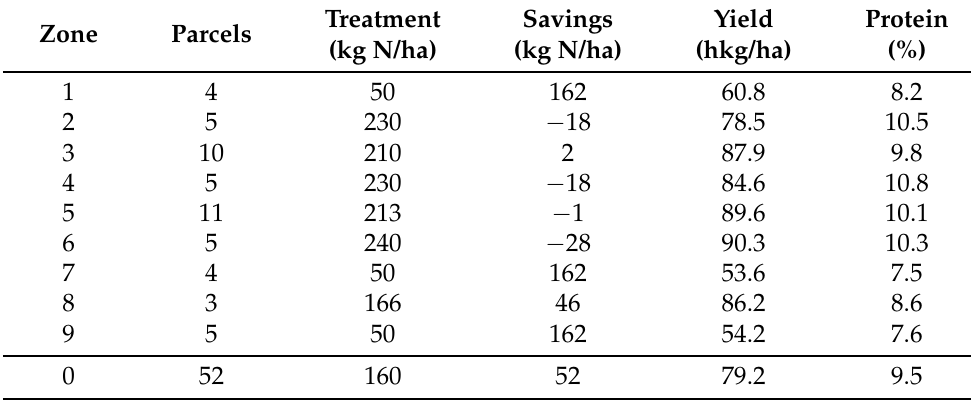
Table 8. Expected savings and mean-performance for each zone at